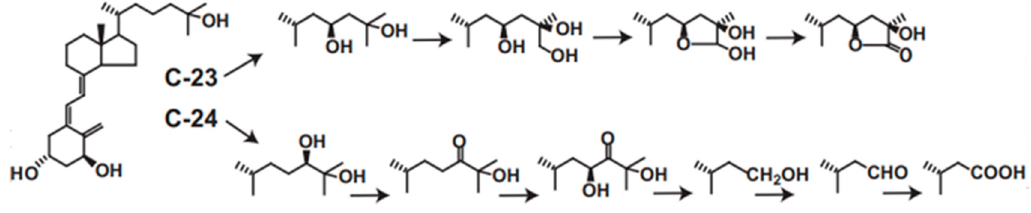
Figure 3. C-23 and C-24 oxidative pathways of 1 α ,25(OH) 2 D 3 catalyzed by human CYP24A1. Human CYP24A1 catalyzes 6-step mono-oxygenation from C-24 hydroxylation to produce calcitroic acid, and 4-step mono-oxygenation from C-23 hydroxylation to the lactone formation.